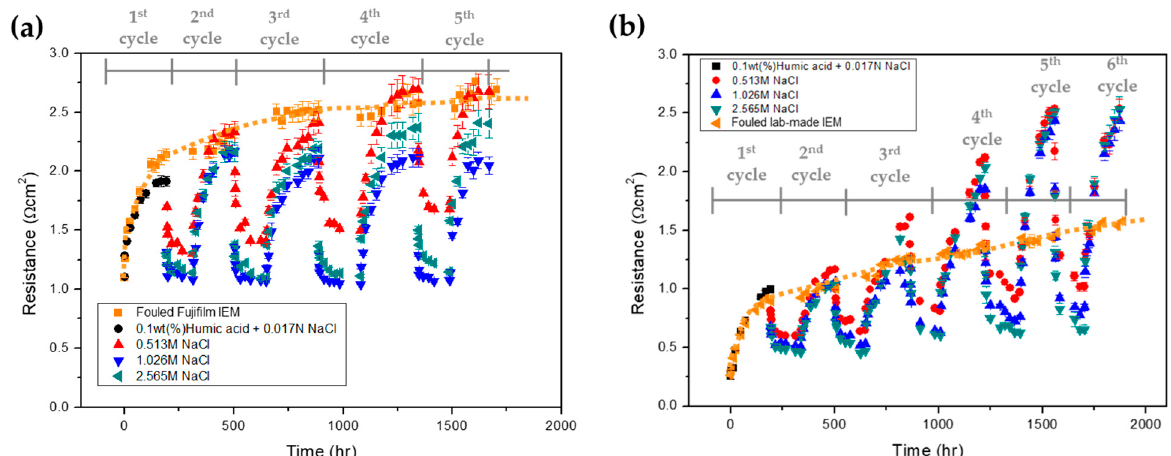
Figure 7. Variation of the averaged electrical resistance of a cell pair using ( a ) the fouled Fujifilm ® and ( b ) the fouled lab-made IEMs in a bench-scale RED stack (the dotted lines represent the variation of electrical resistance for the fouling in no presence of mitigation).